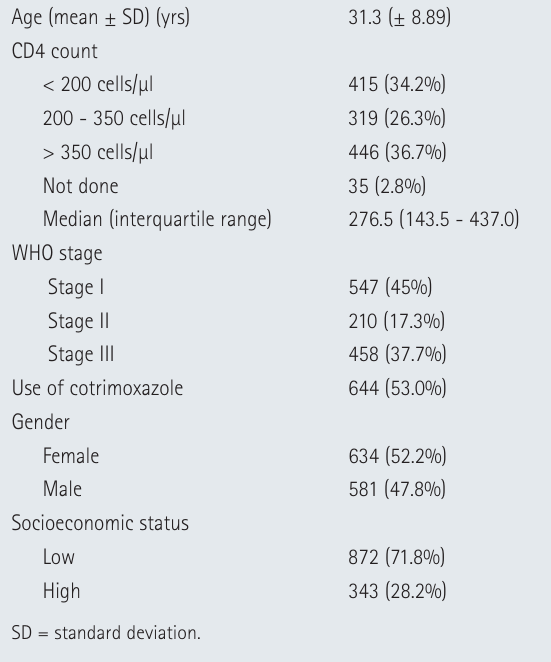
TABLE I. BASELINE CHARACTERISTICS OF THE